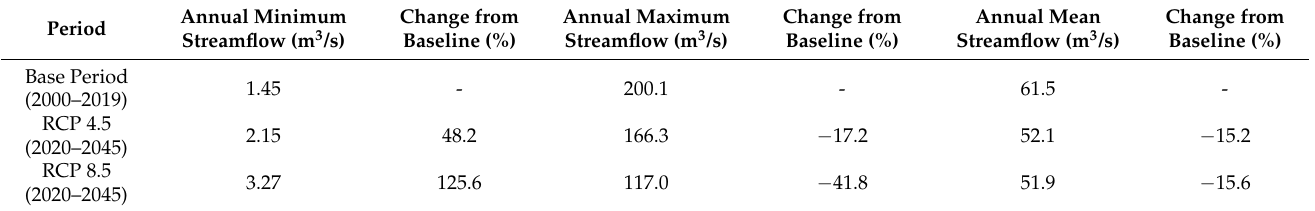
Table 4. Projected changes (%) in the annual mean, minimum, and maximum streamflow (m 3 /s) under the RCP 4.5 and 8.5 in comparison to the base